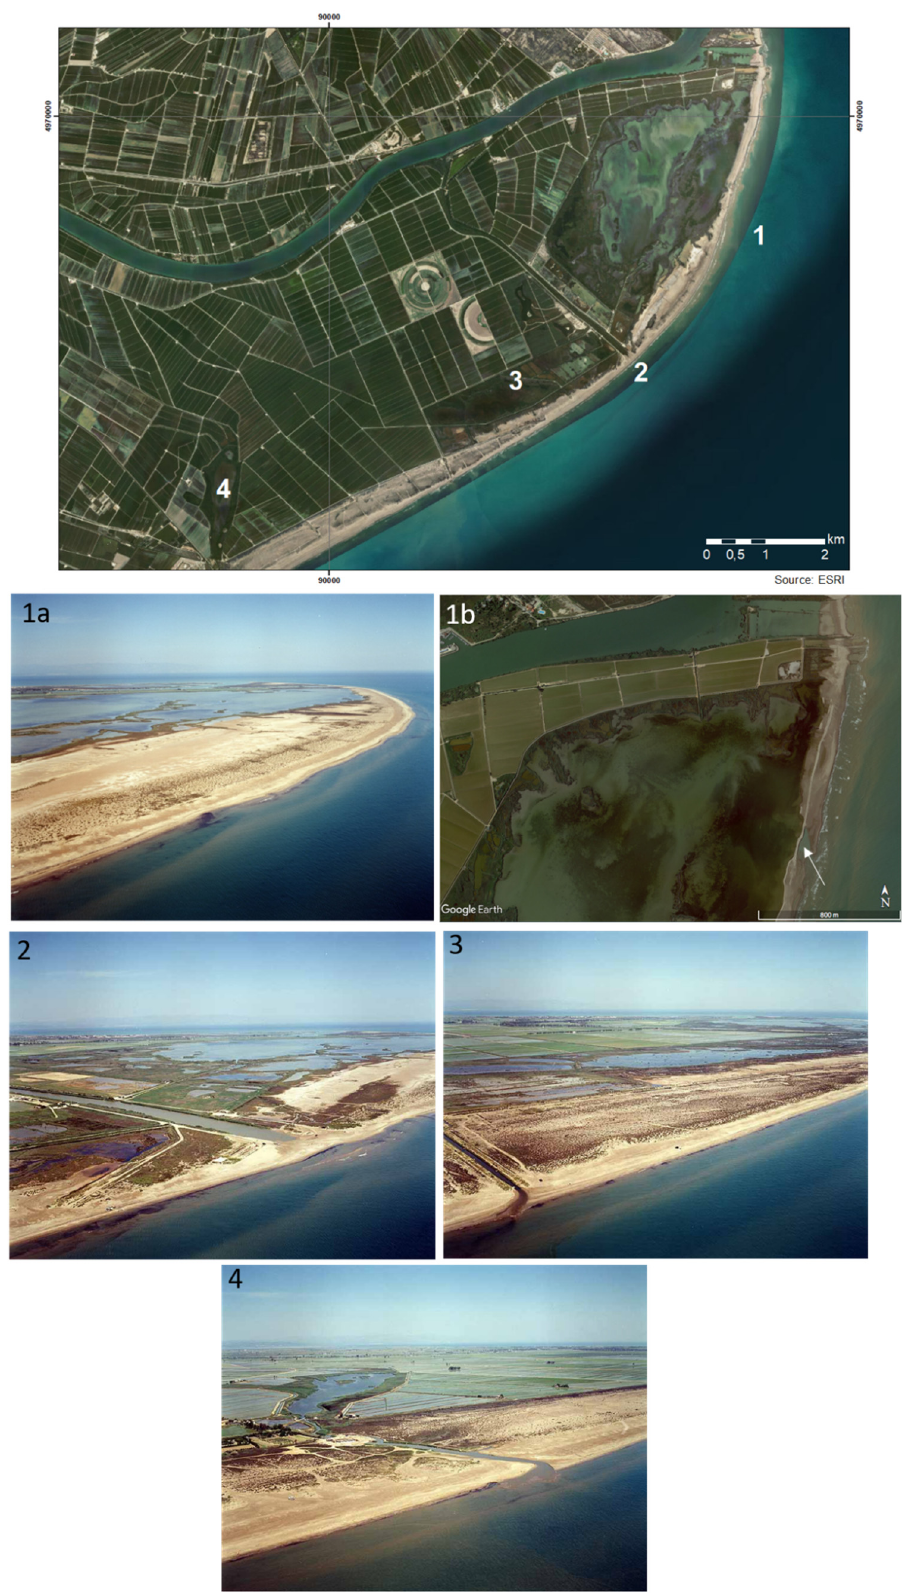
Figure 3 . Images of the hemidelta south next to the mouth. ( 1a ) Buda Island; ( 1b ) Buda Island Break; ( 2 ) Migjorn mouth; ( 3 ) L’Alfacada Lagoon; ( 4 ) El Serrallo Beach and La Platjola Lagoon. (Source: General view: ESRI Co.; Photographs 1, 2 and 3: Guide of beaches of the Ministry for the Ecological Transition and the demographic challenge; Image ( 1b ): Google Earth).